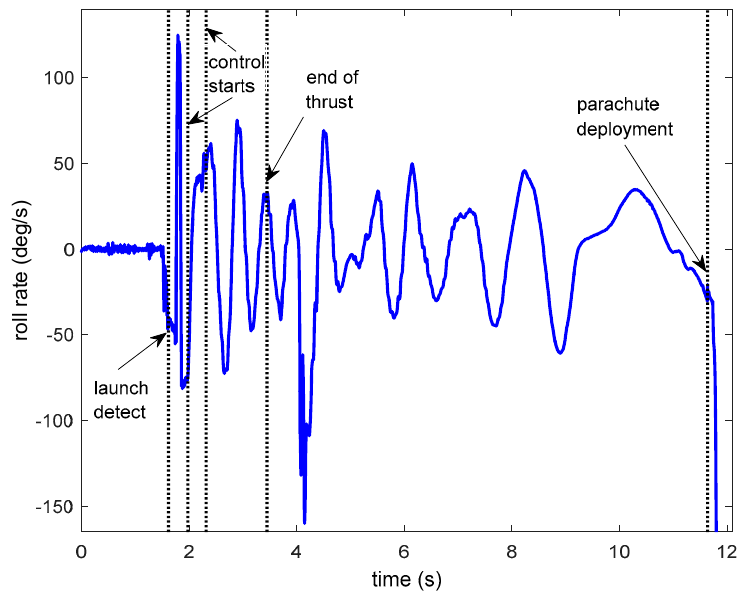
Figure 26. Input signal applied to PD Controller ( t = 0 corresponds to start of controller).